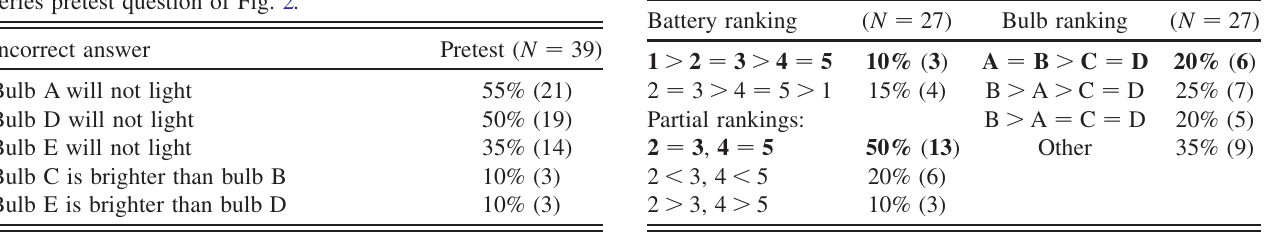
FIG. 2. Circuit diagrams used in multiple batteries in series pretest. Students are asked to rank the bulbs by brightness, and explain the reasoning behind their